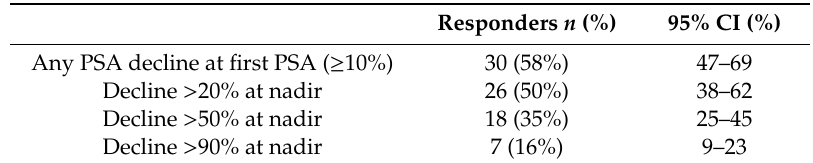
Table 2. PSA response characteristics.